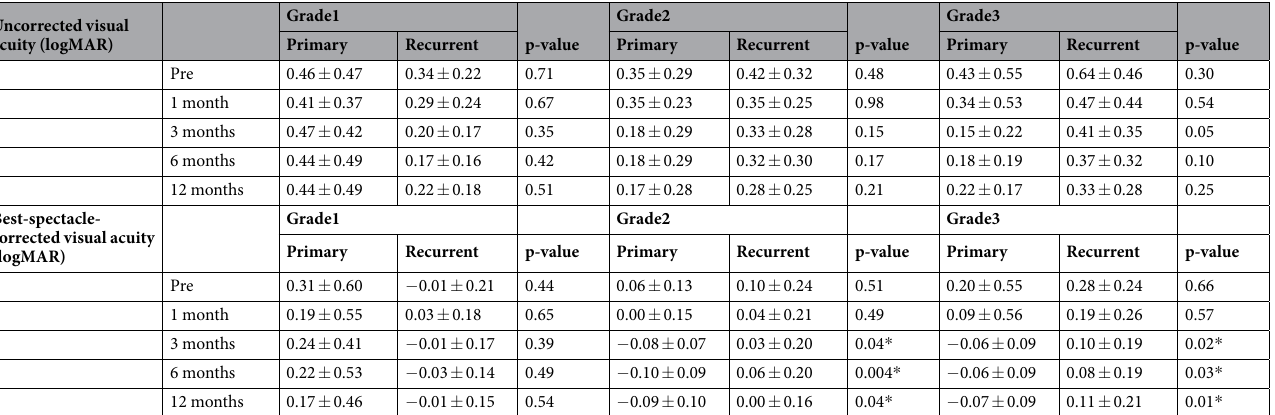
Table 5. Uncorrected and best-spectacle-corrected visual acuity of patients with each grade pterygium. * p < 0.05. logMAR: logarithm of the minimum angle of resolution. All values are presented as mean ± standard